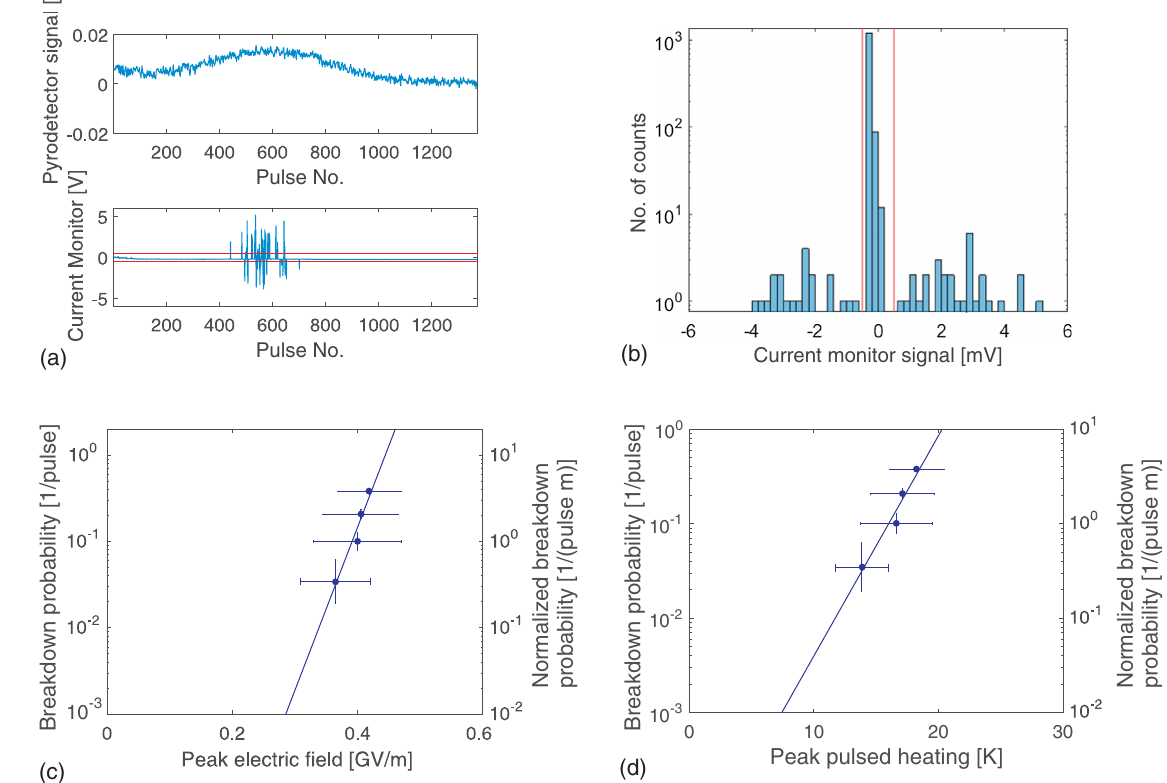
FIG. 20. Breakdown rate measurements, achieved during a horizontal scan of the copper structure with a 1.5 mm gap, with 3.2 nC of ¼ 50 μ m, plots of the pyrodetector signal and of the arc detector, showing that the arc probability increases with the bunch charge and σ z gradient (a), the histogram of the distribution of the current monitor voltages (b), the breakdown rate as a function of the peak electric field (c), and as a function of the peak pulsed heating (d).